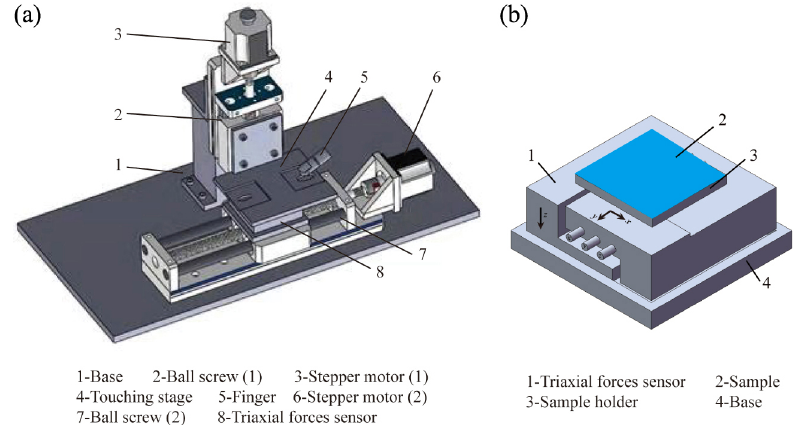
Fig. 2 Schematic diagrams of (a) friction tester and (b) triaxial force